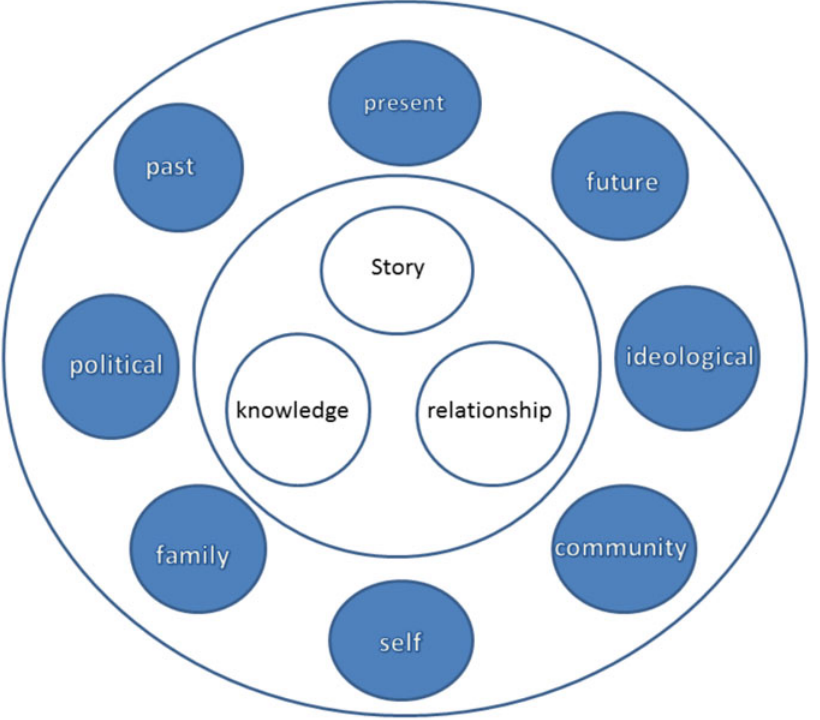
Fig. 1. Collaborative Yarning Methodology (Shay,